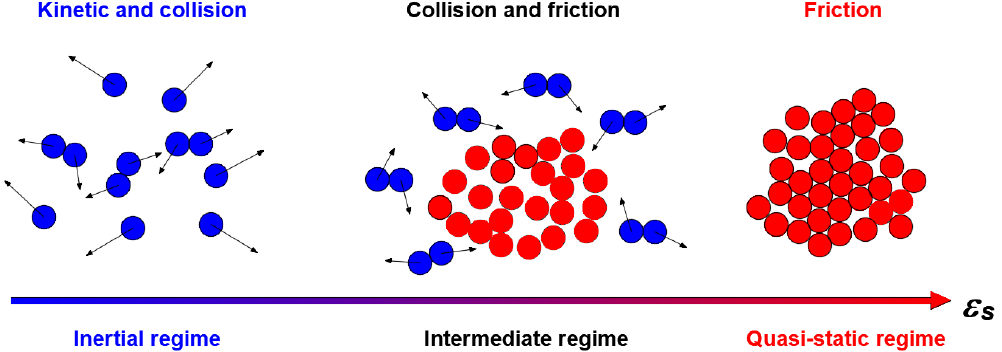
Figure 1. Interaction mechanisms among particles at different flow regimes.